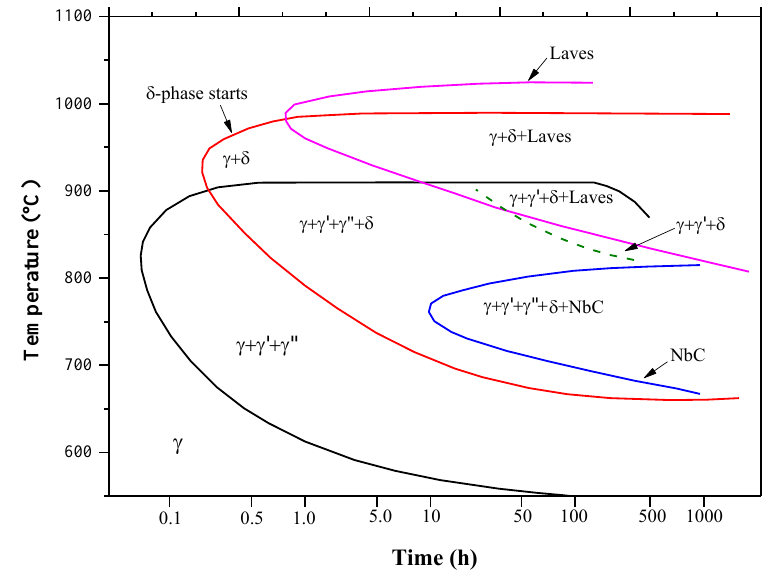
Figure 3. Transformation-time-temperature diagram of IN718 alloy system. Reproduced with the permission from [23]. Copyright American Welding Society, 1986.